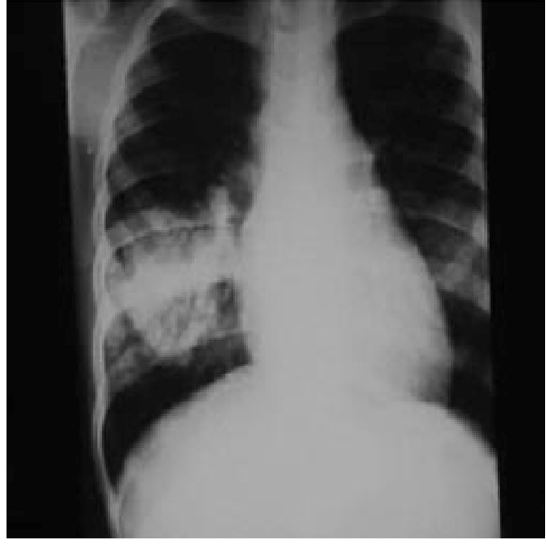
Figure 1. CXR shows a rounded, well-delineated shadow on the right lower lung zone. The electrocardiogram was normal. The big blow to the diagnosis of cyanotic heart disease came from her echocardiography, which revealed a completely normal heart. So why is the child cyanotic? I